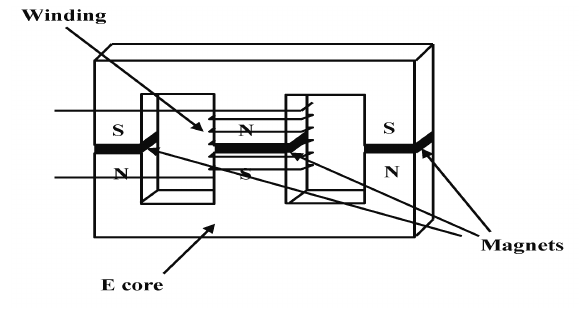
Figure 2: Passive FCL Physical Configuration